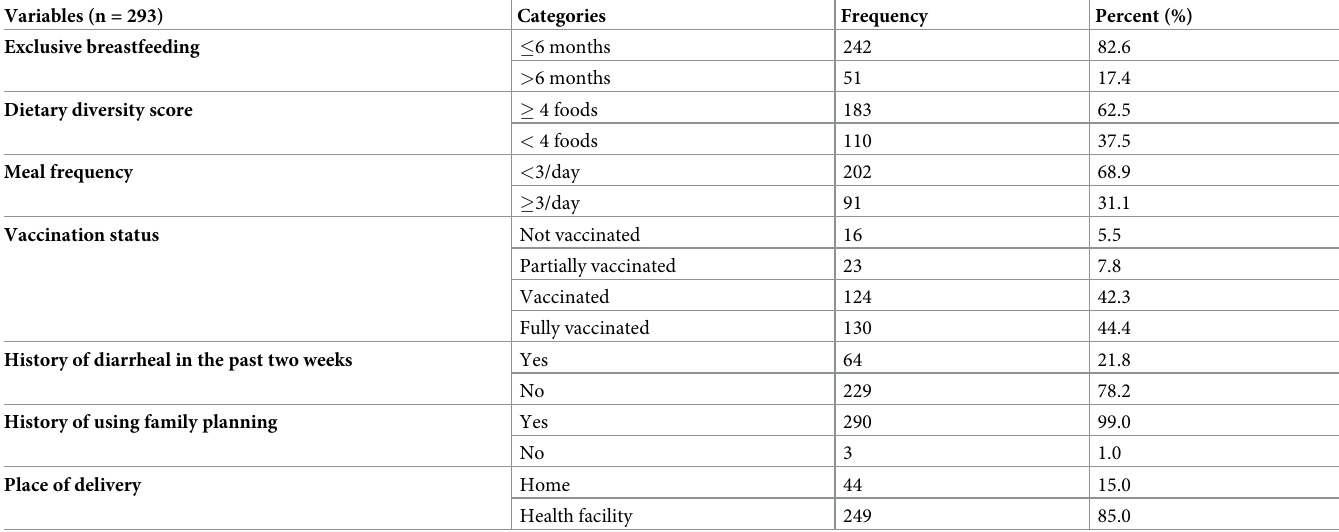
Table 2. Child caring practice and health characteristics of the study participants in Wolkite town, 2020/2021.